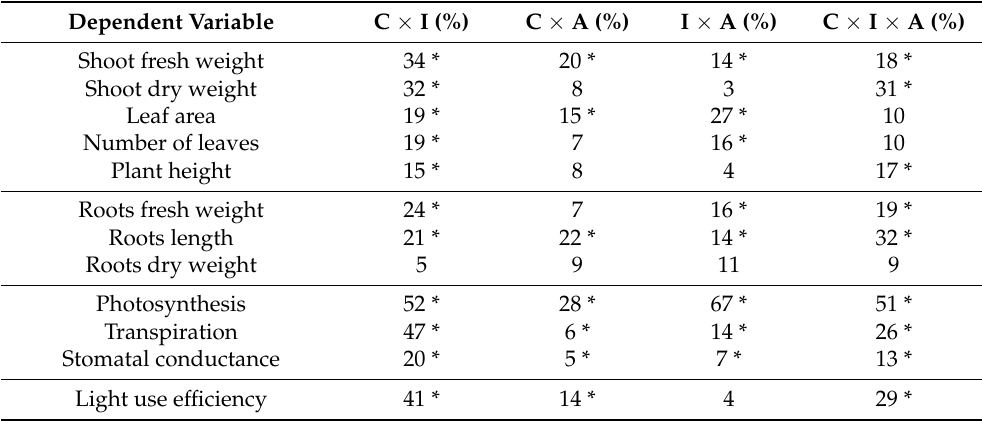
Table 3. Effect size of the two- and three-way interactions between CO 2 concentration, illumination intensity and air speed on the growth, gas exchange and light use efficiency of lettuce plants grown under artificial lighting.